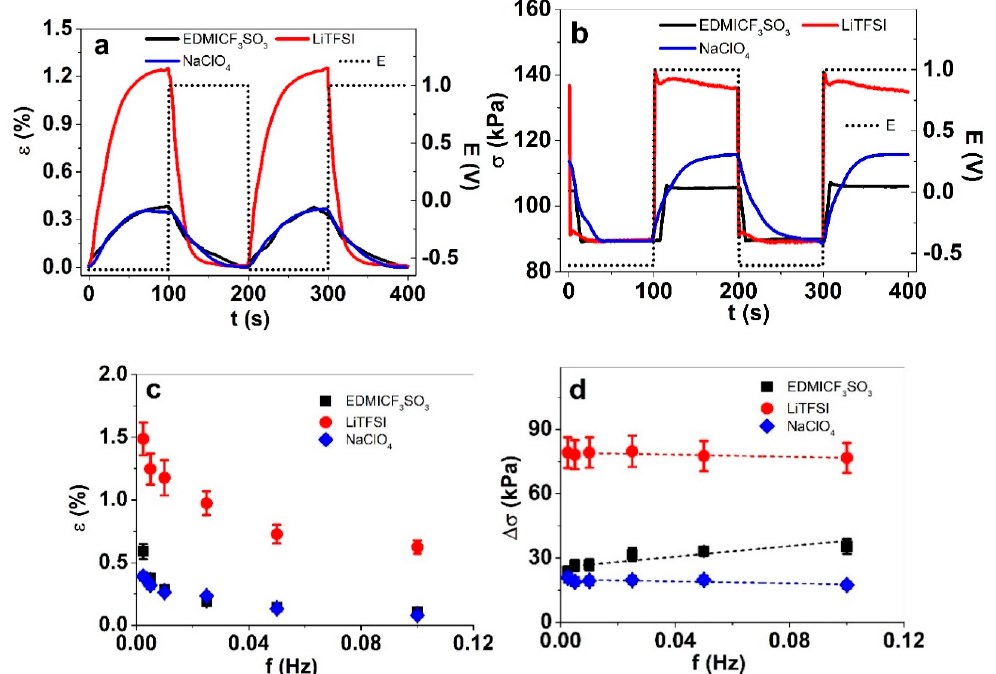
Figure 3. Square wave potential step (1.0 to − 0.6 V, 0.005 Hz, 3rd and 4th cycle) response of PP–IPN trilayers in EDMICF 3 SO 3 ( ■ , black), LiTFSI ( ● , red) and NaClO 4 ( ♦ , blue) of ( a ) strain vs. time; ( b ) stress vs. time, with potential E (dotted); ( c ) strain vs. frequency; ( d ) the stress difference Δσ vs. frequency. The dotted lines in d show the linear fit, for orientation only.